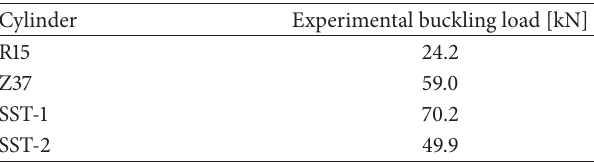
Table 4: Experimental buckling load of tested